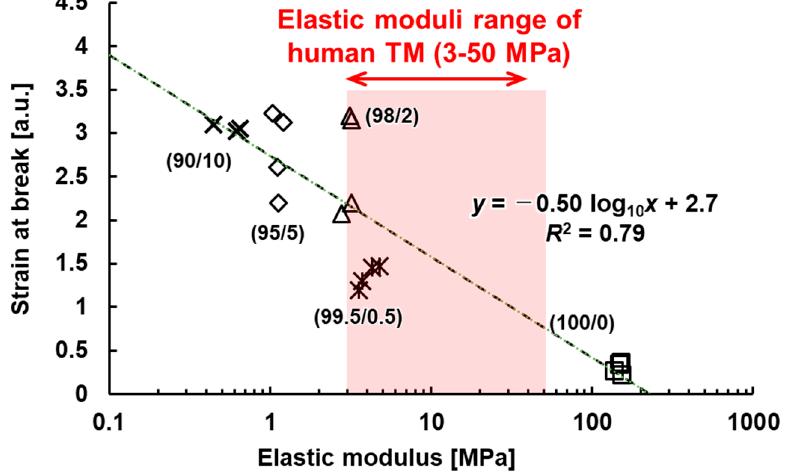
Figure 7. Stress–strain behavior of trabecular meshwork model. Numbers indicate the weight ratio of the PVC/DEHP mixture. Figure 8. Elastic modulus and fracture strain of various concentrations of PVC/DEHP.